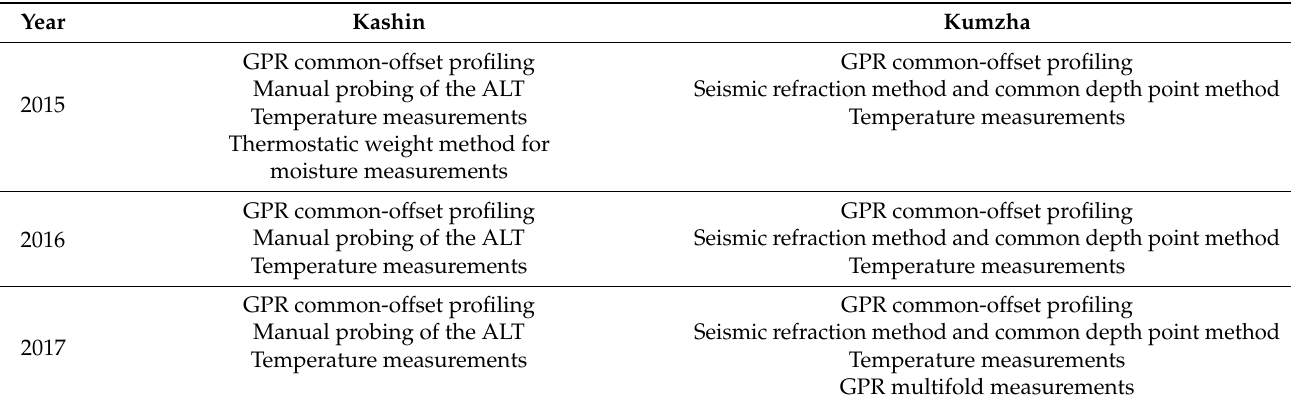
Table 1. Research methods at the Kashin (CALM 24) and Kumzha (CALM 24A)